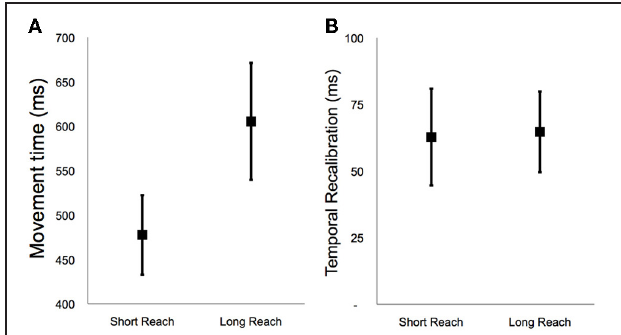
FIGURE 2 | (A) Average movement time during short and long reach baseline conditions during Experiment 1. (B) Average temporal recalibration estimates during the short and long reach conditions of Experiment 1. Error bars depict ± 1